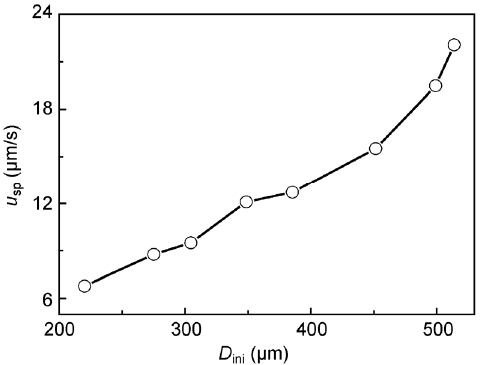
Fig. 4 Influence of droplet size on spreading velocity, PAO100, w = 42 N.